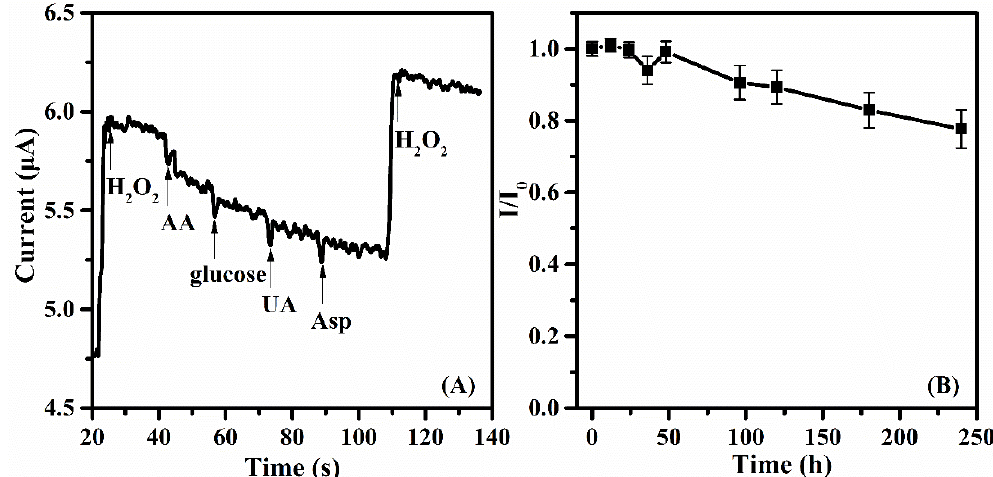
Figure 11. ( A ) Amperometric responses of C 12 -PPy-Au/GCE biosensor upon successive additions of